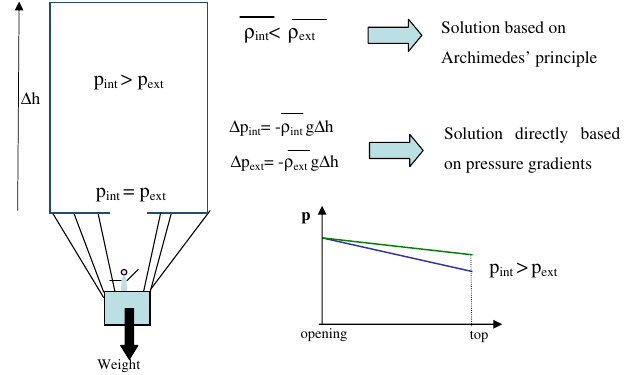
FIG. 5. Main elements of two explanations for the sustentation of a hot air